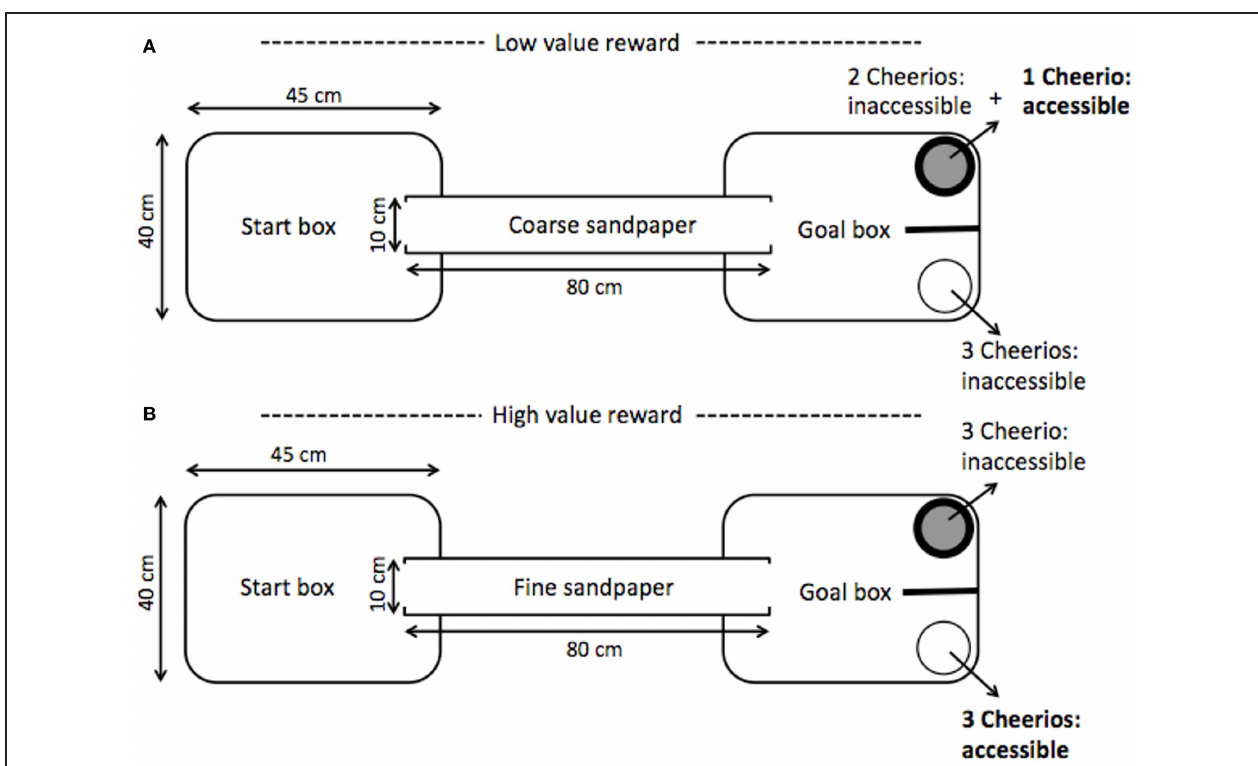
FIGURE 3 | Schematic of cognitive bias testing chamber adapted from Brydges et al. (2011). Within a daily session, 2 trials of each example panel were presented. (Panel A ) depicts a low-value reward trial; the coarse sandpaper provided a cue that the low-value (1 Cheerio) reward was accessible whereas the fine sandpaper indicated a high-value reward (3 Cheerios) was present (Panel B ). Sandpaper grade, bowl color, bowl side, and reward value pairings were counterbalanced. To balance scent cues from the rewarded and unrewarded bowls inaccessible Cheerios were present beneath a mesh barrier.